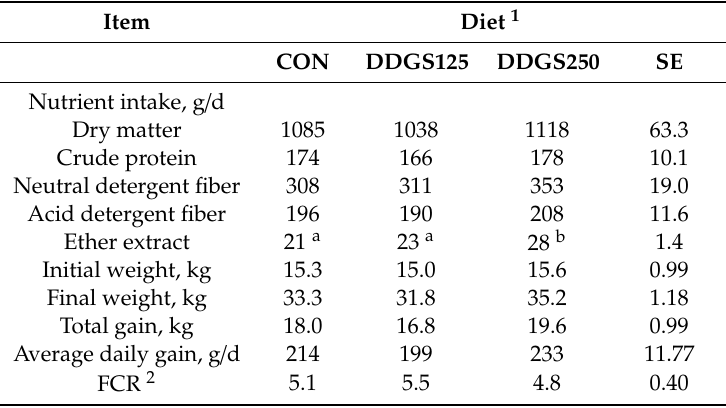
Table 2. E ff ects of feeding dried distillers’ grains with solubles (DDGS) on nutrient intakes and growth performance of growing Awassi lambs.